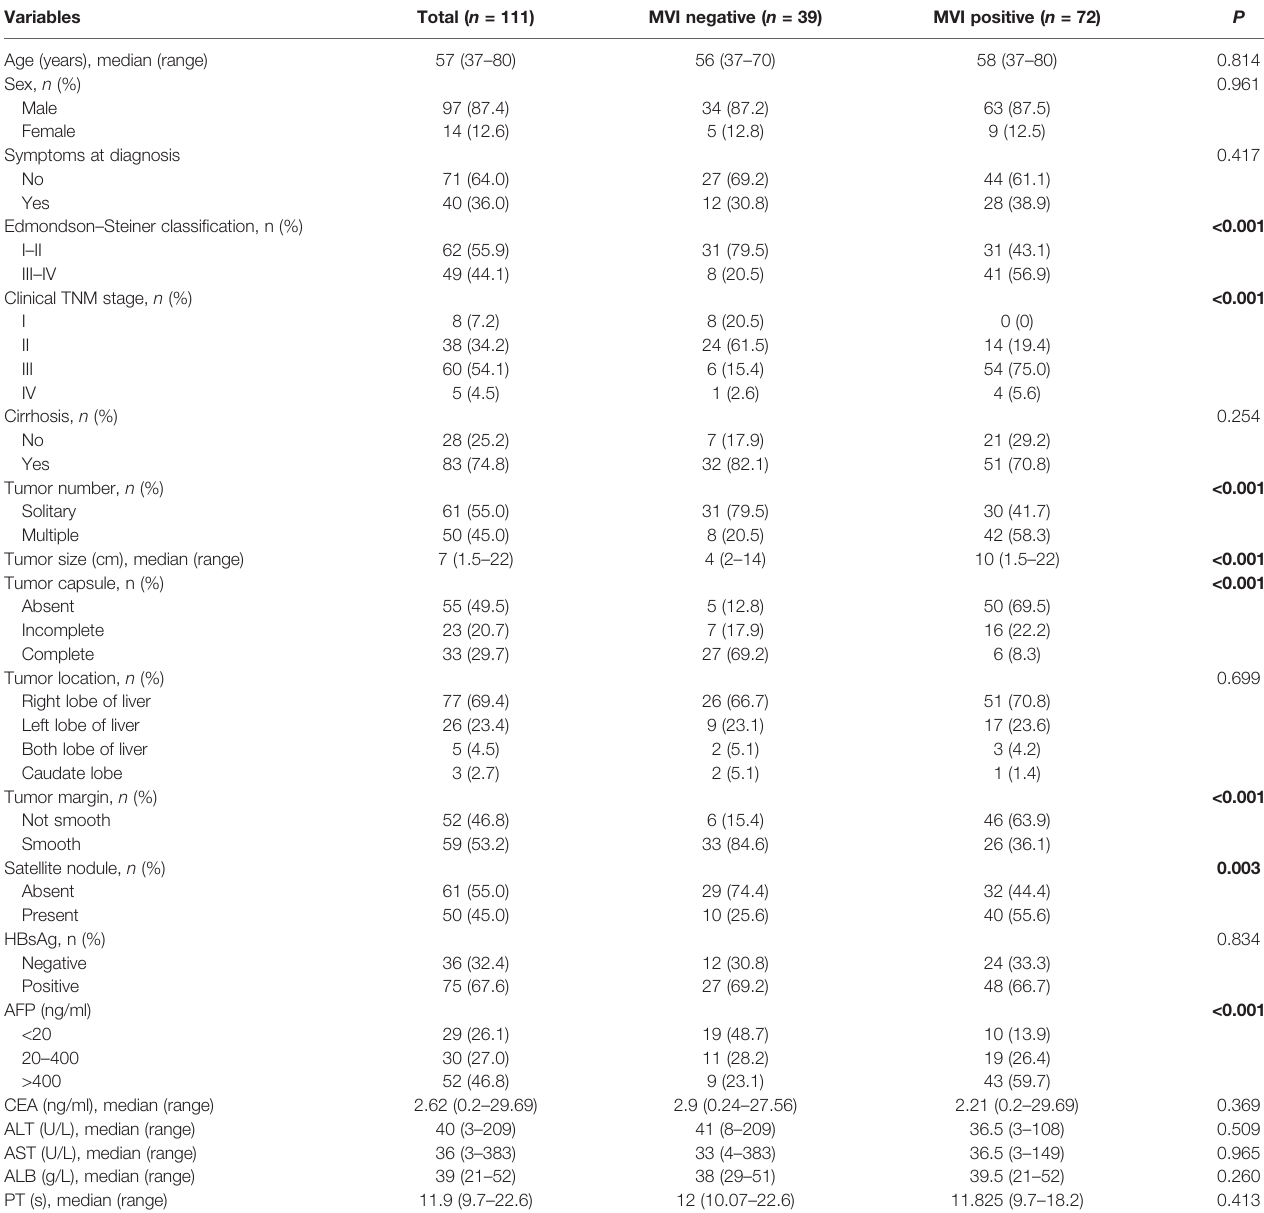
TABLE 1 | Clinical characteristics of HCC patients and their correlations with MVI status.